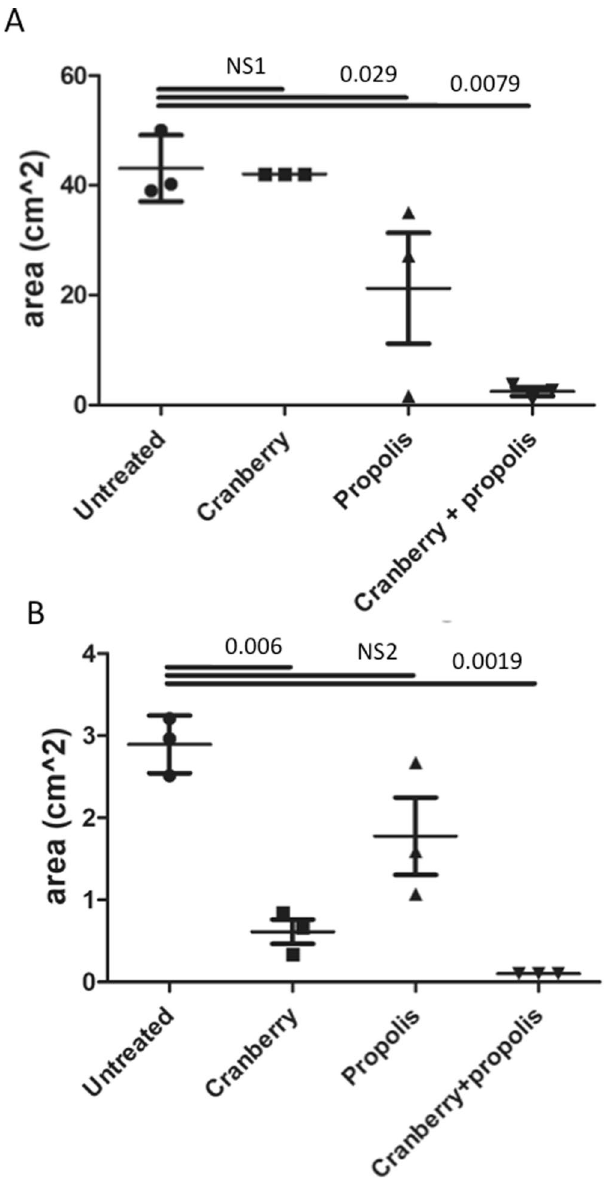
least two independent assays. A. NS1, not significant: p > 0.9999; B. NS2: p =